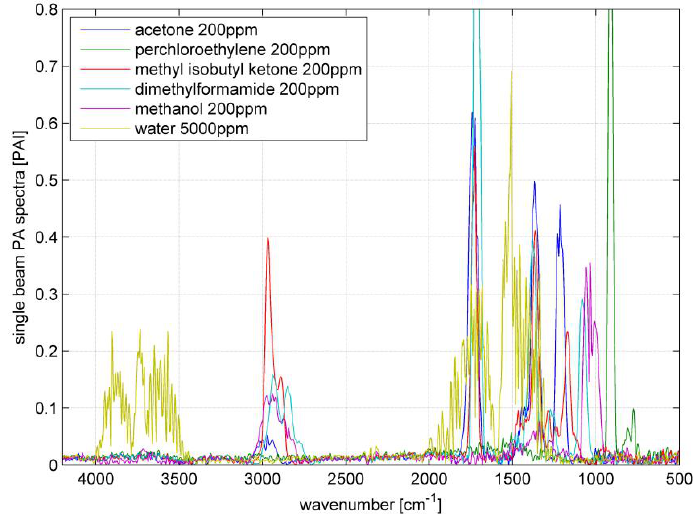
Figure 5. Selectivity experiment: Spectra of the five VOCs and water.